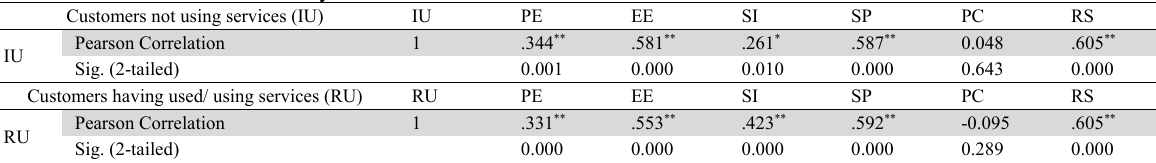
Results of Pearson correlation analysis